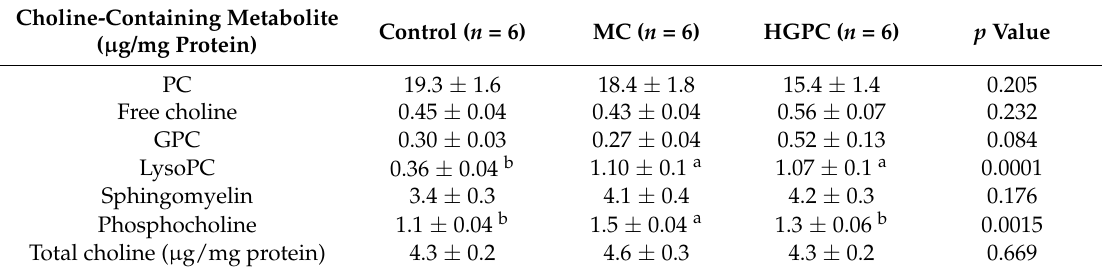
Table 3. Choline-containing metabolites in splenocytes of lactating dams fed Control (100% FC), Mixed Choline (MC; 50% PC, 25% FC, 25% GPC) or High GPC (HGPC; 75% GPC, 12.5% PC, 12.5% FC) diets.